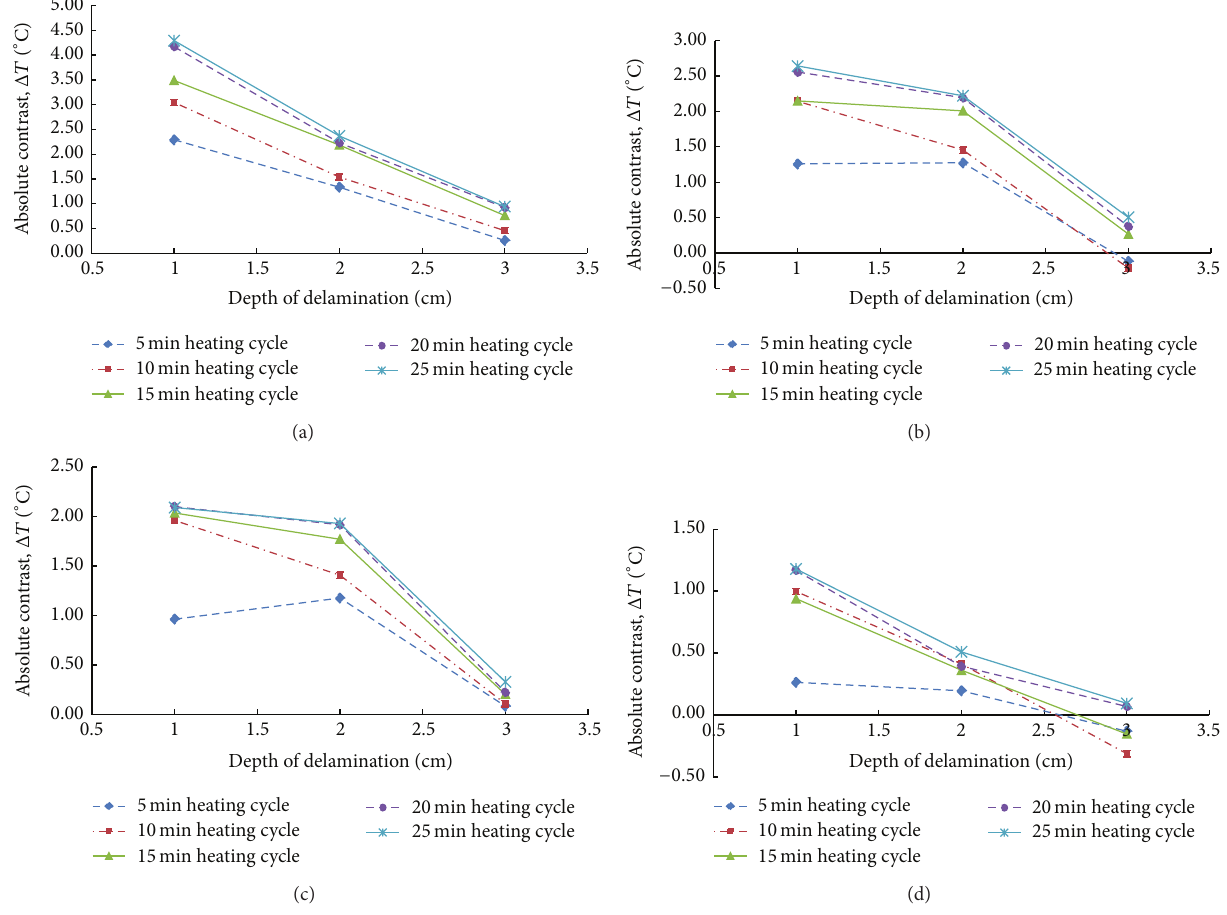
Figure 7: Relationship between the absolute contrast and the depth of delamination for the sizes: (a) 10 × 10cm, (b) 7 × 7 cm, (c) 5 × 5 cm, and (d) 3 × 3cm.